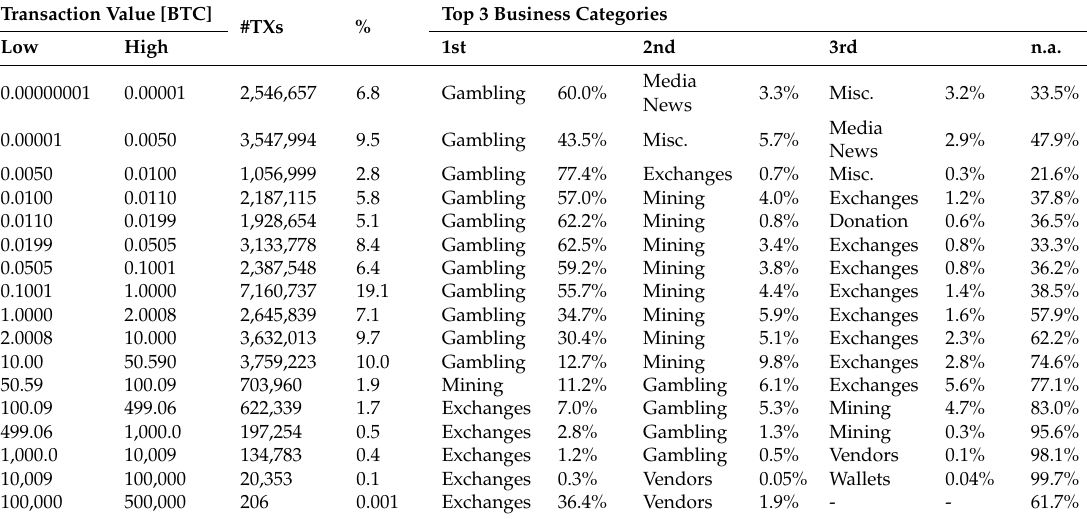
Table 4. Transaction Value Distribution.